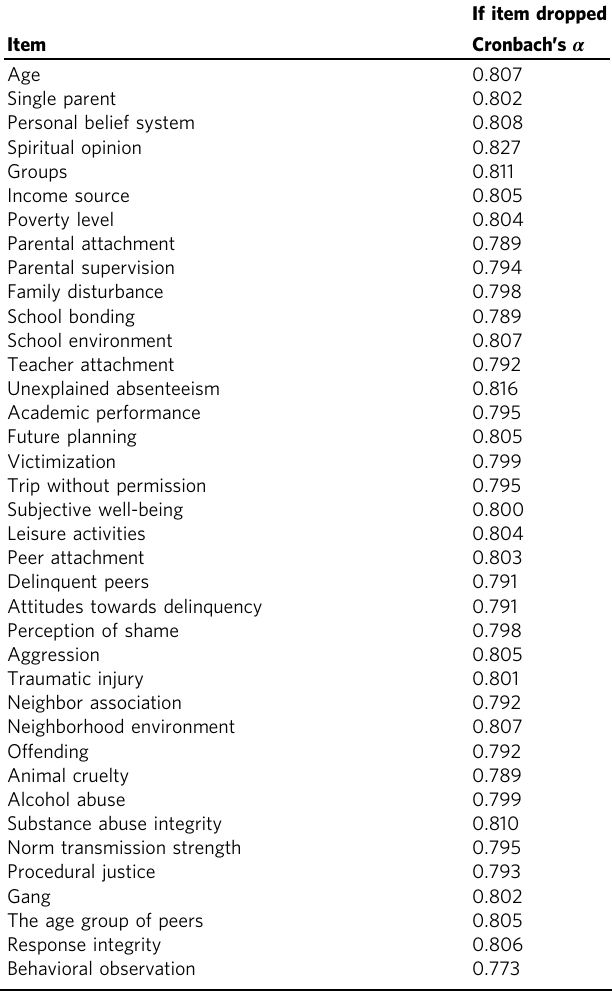
Table 3 Reliability statistics of frequentist individual